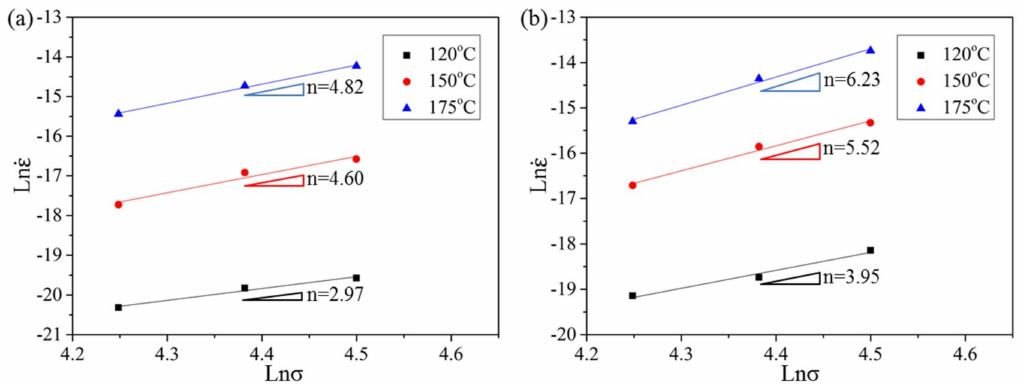
Figure 10. Stress dependence of the steady creep rate at 120–175 ◦ C for ( a ) HRRed and ( b ) T5 specimens.